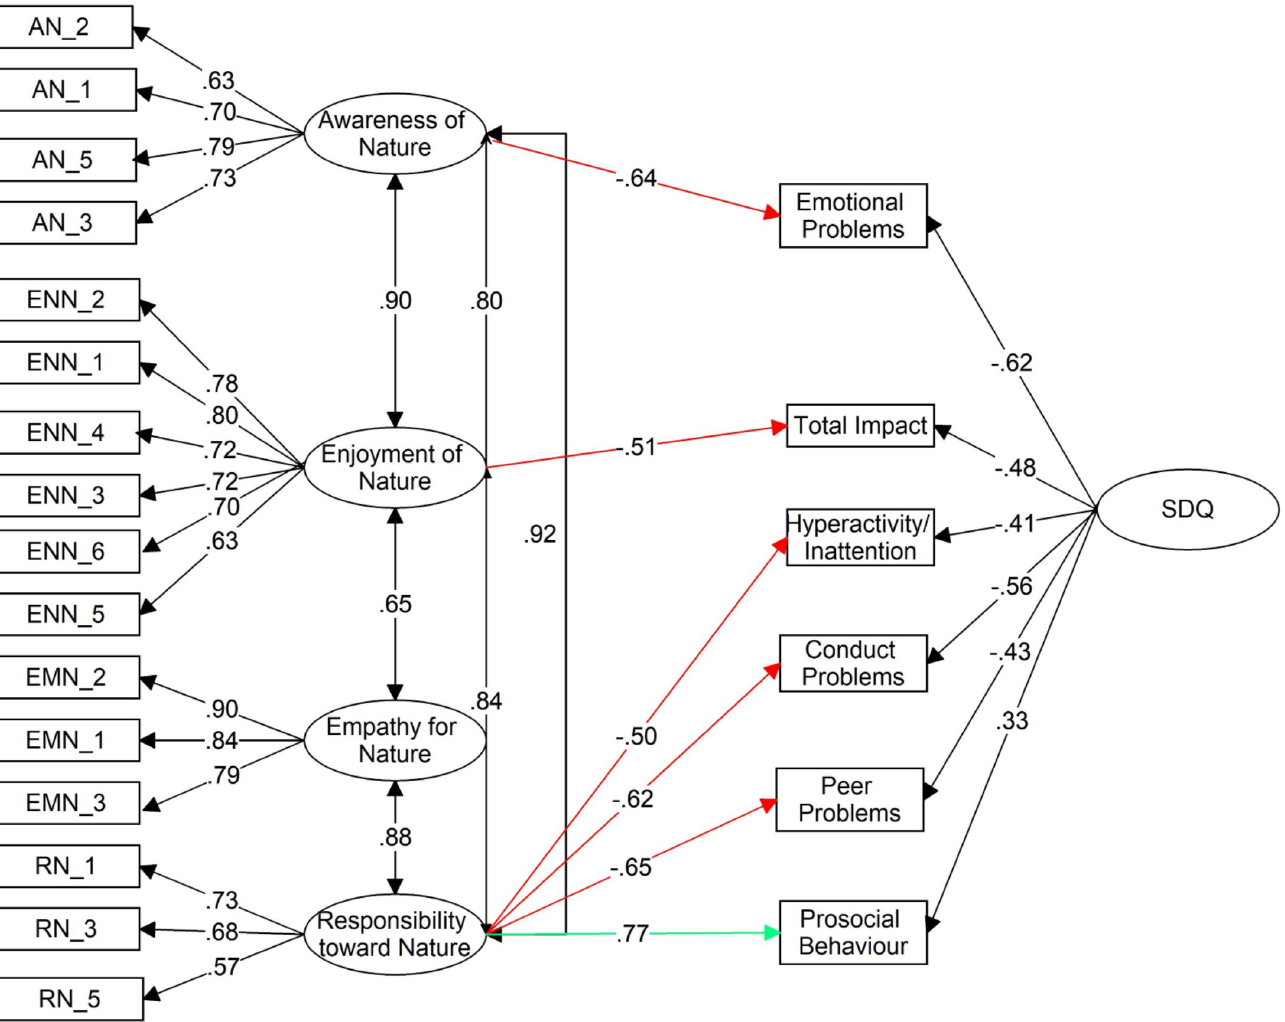
Fig 1. CNI-PPC as predictor of SDQ score. Note. Values are standardized; paths from CNI-PPC to SDQ scores shown as red when negative, green when positive; R 2 values for SDQ scores displayed.